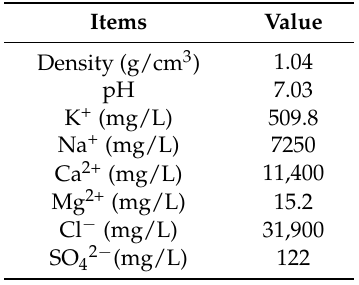
Table 2. Physicochemical properties of the reservoir brine sample.